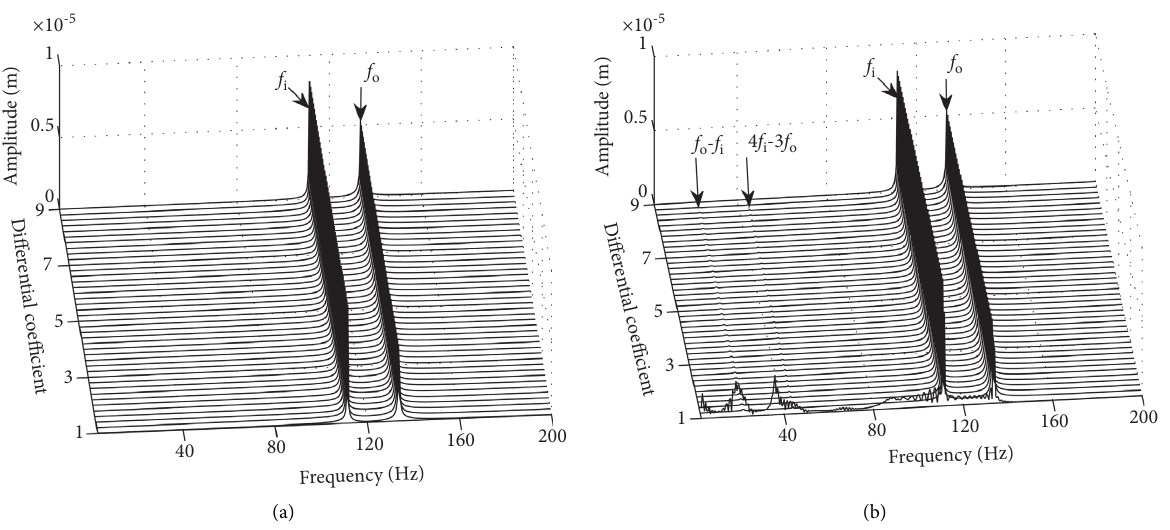
Figure 23: Waterfall plots of the MSDS with K